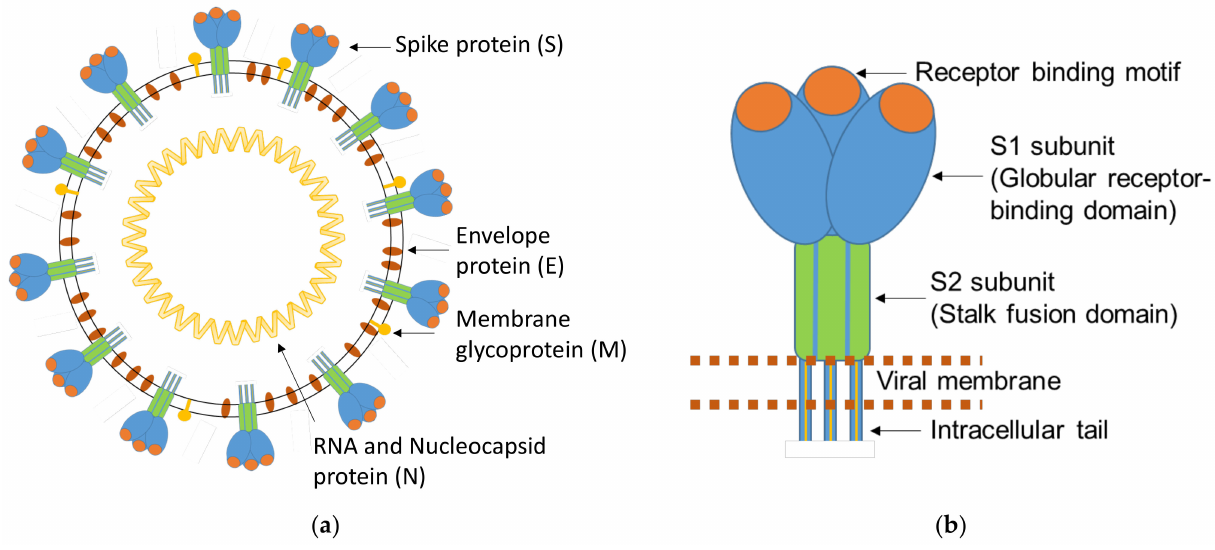
Figure 1. ( a ) Schematic representation of a SARS-CoV-2 virion; ( b ) enlarged scheme of the trimeric structure of the SARS-CoV-2 S protein. Adapted from Mittal et al.